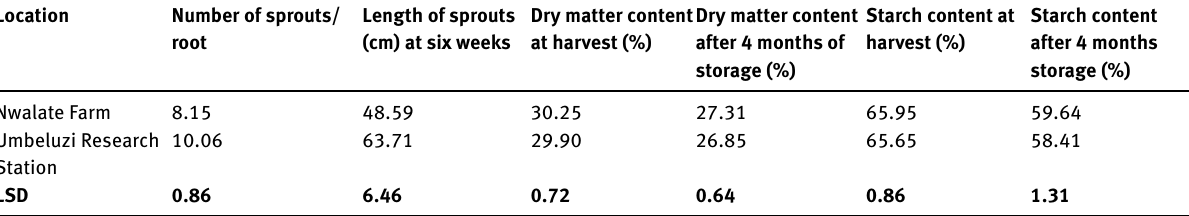
Table 4: Effect of locations on means of number of sprouts per genotype, length of sprouts measured at six weeks after sprouting (cm), dry matter content at harvest and four months after storage (%) and starch content at harvest and four months after storage (%) from analysed data collected at Umbeluzi Research Station and Nwalate Farm in 2015, 2016 and